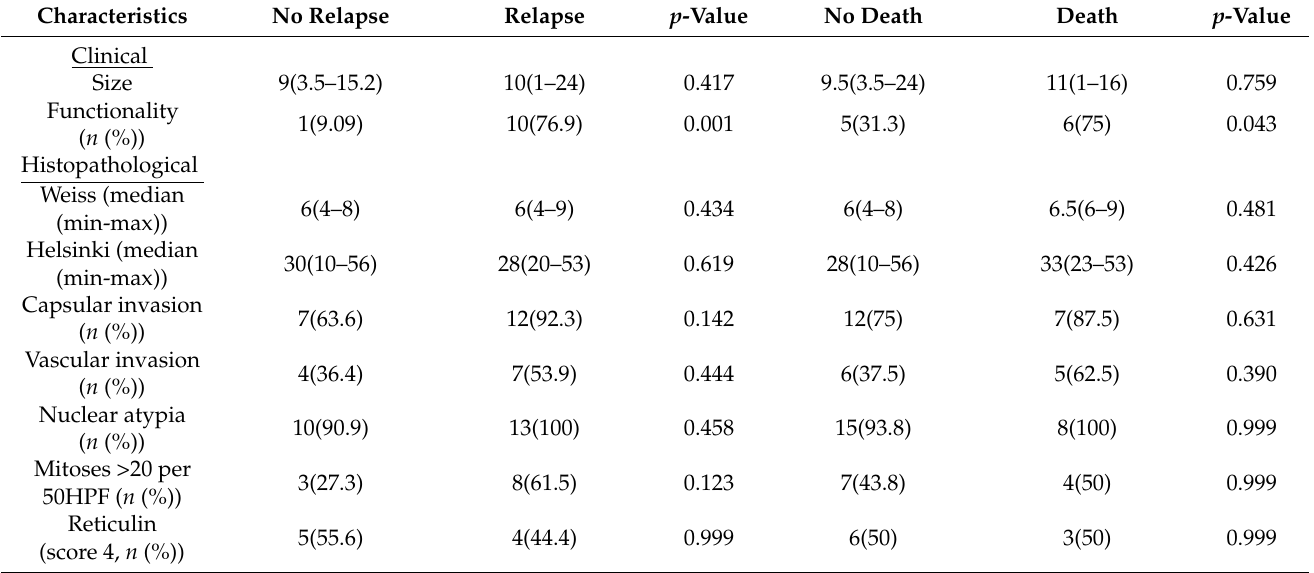
Table 3. Association of clinical, histopathological and immunohistopathological markers with prognostic factors.